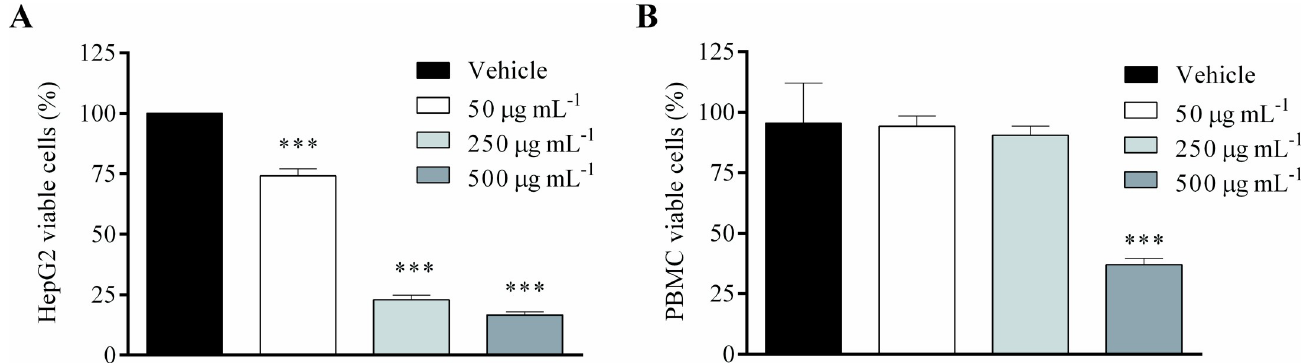
Fig 4. Cell viability of HepG2 (A) and PBMC (B) cells treated with the alkaloid and acetogenin-rich fraction of Annona crassiflora fruit peel (AF-Ac) or vehicle (control, cells treated with DMEM medium containing 0.05% DMSO for HepG2 cells or RPMI-1640 containing 0.05% DMSO for PBMC cells). Results (mean ± SD, n = 3) expressed as the percentage of viable cells compared to the vehicle group. Significance levels are indicated by ��� p < 0.001 when compared to control (one-way ANOVA and Dunnett as posttest).